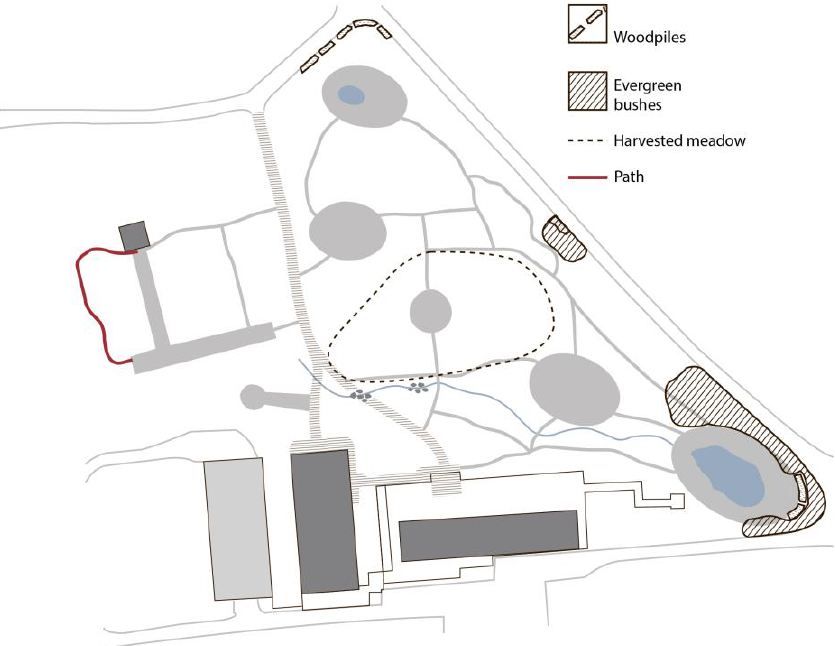
Figure 6. Operation traces resulting from maintenance tasks carried out by staff assisted by participants.